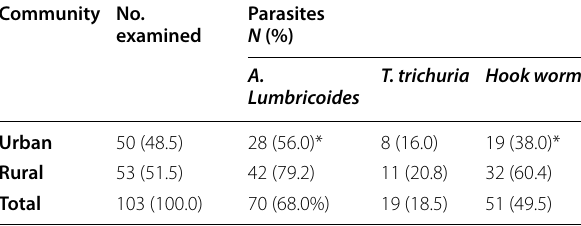
Values asterisk (*) connotes significant difference in a column